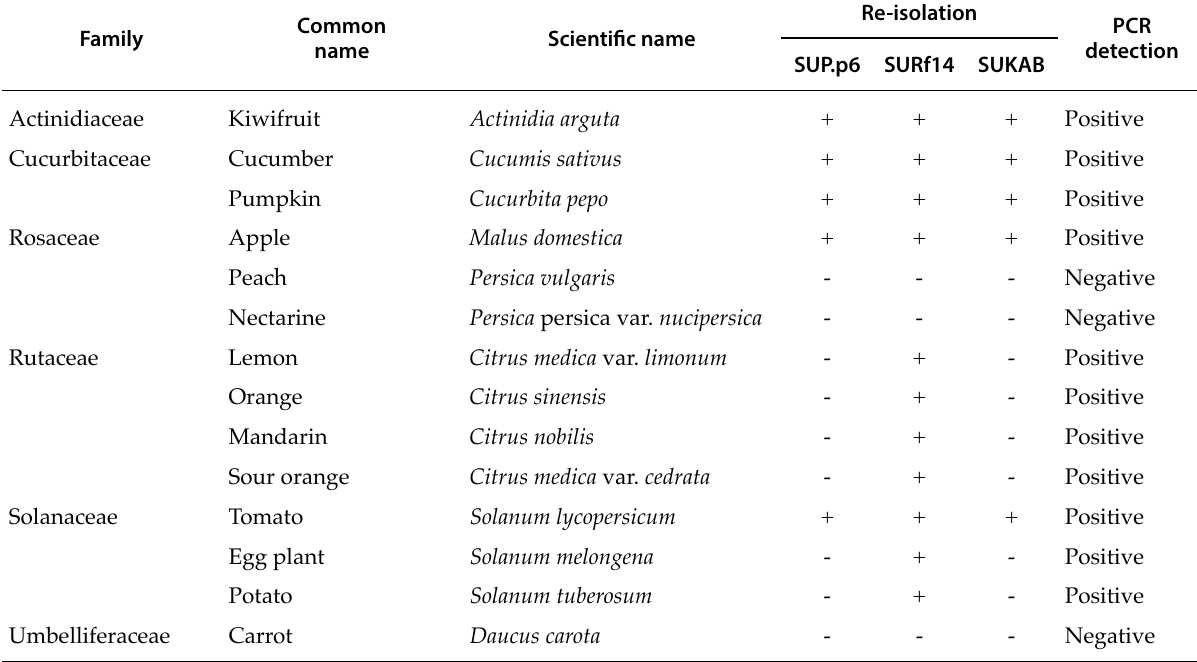
Table 4. Susceptibility of fruits, tubers and storage roots to Phytophthora pistaciae isolates.